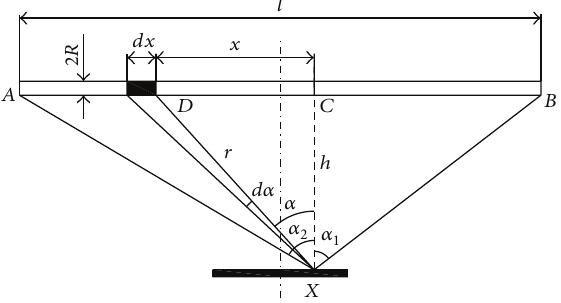
Figure 2: Irradiance of solar cell from